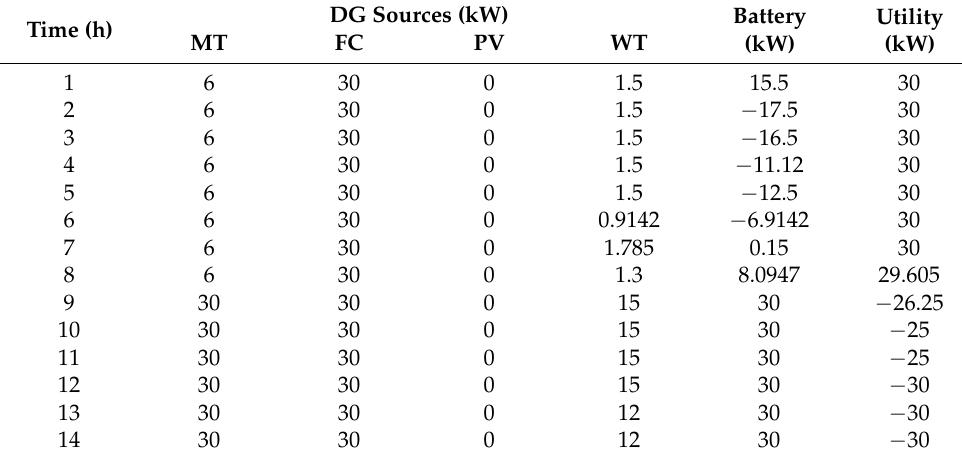
Table 6. Economic dispatch for Scenario